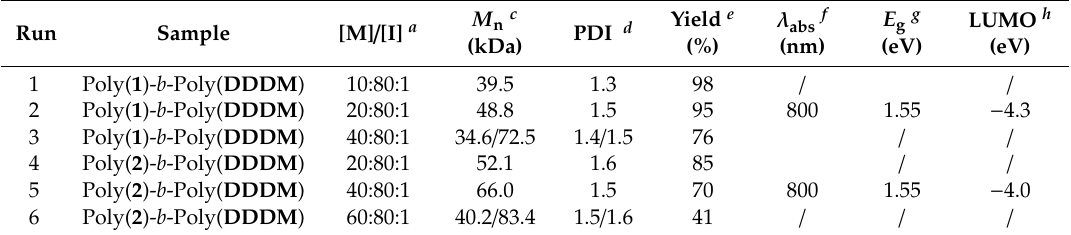
Table 1. Gel permeation chromatography (GPC) data and photophysical properties of the resulted polymers.